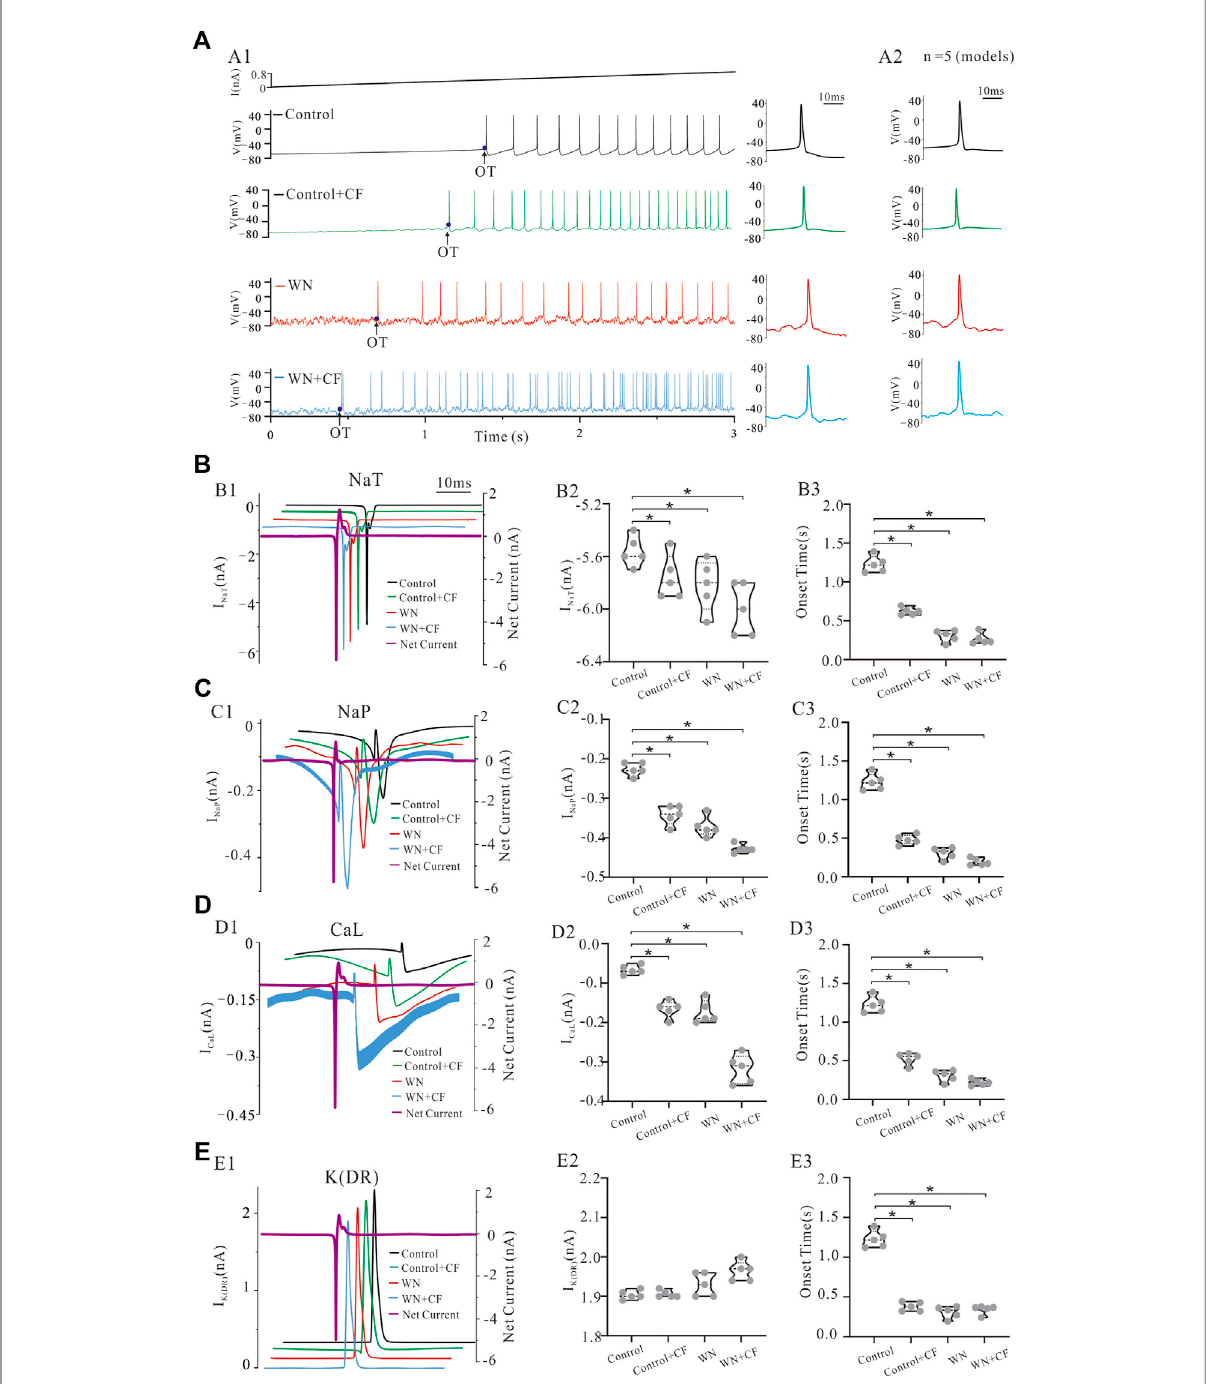
FIGURE 9 Channelmechanismsunderlyingmembranepotentialoscillationseffectsonspikeinitiation.Thestatisticaldatapresentedbelowwererecorded withcurrentramp peakof1 nA. (A) A rampcurrentwithaduration of3 sand peakof1 nA wasinjectedintoamodelHG motoneuroninconditionsof control,control+CF,WNandWN+CF,respectively.Theonsettime(OT)ofthe fi rstspikeoftrainwasrecorded,andtheaveragedAPsfrom A1 were shown in theright insets (control: black; Control + CF: green; WN: red; WN + CF: blue),and theaveraged APs calculated from the fi vemodeled HG motorneurons (Table 1) with the same conditions were shown in A2 . (B) Ionic currents recorded in control, Control + CF, WN and WN + CF. Control + CF (NaT), WN, and WN + CF (NaT) slightly increased NaT currents (B1,B2) thus increasing the net inward current (B1, purple) and dramatically shortened the OT of repetitive fi ring (B3) . (C) Control + CF (NaP), WN, and WN + CF (NaP) also signi fi cantly increased NaP currents